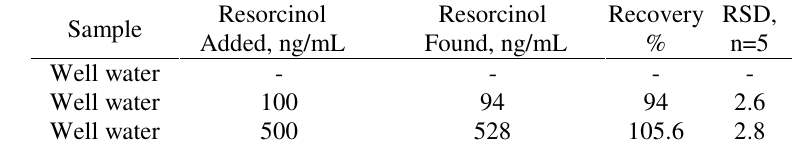
Table 2. Determination of resorcinol in synthetic